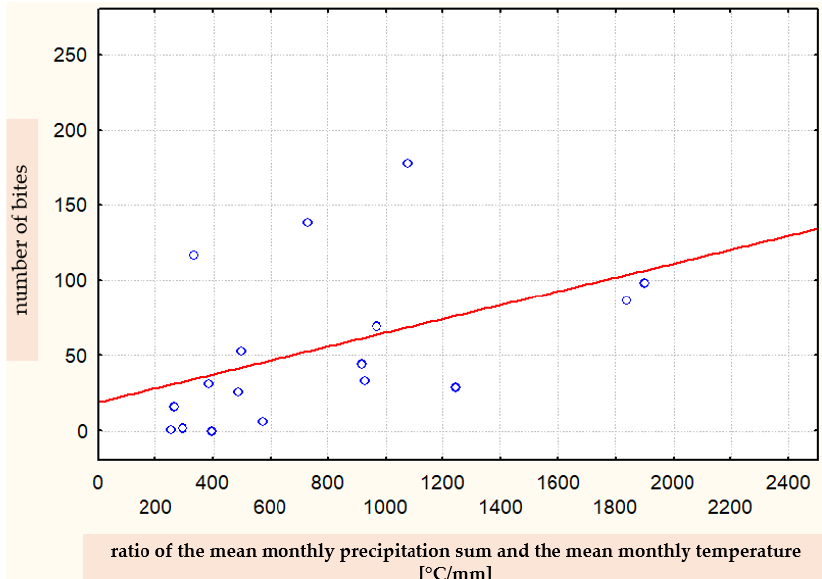
Figure 8. Correlation between the number of bites in a given month and the mean monthly precip- itation sum (Spearman’s rank correlation coefficient R = 0.550).